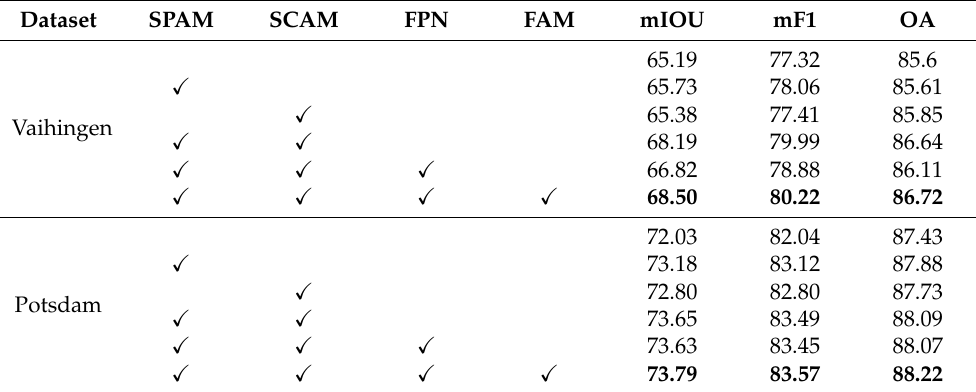
Table 6. Comparisons of different versions of our network on ISPRS Vaihingen and Potsdam datasets. The best results are shown in